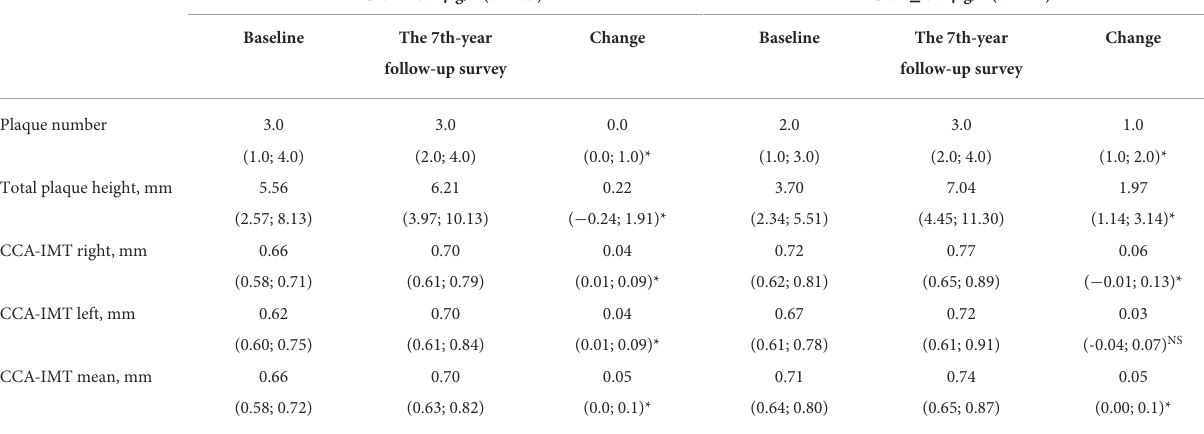
TABLE 4 The ultrasound markers of carotid atherosclerosis and CCA-IMT depending on the mCRP